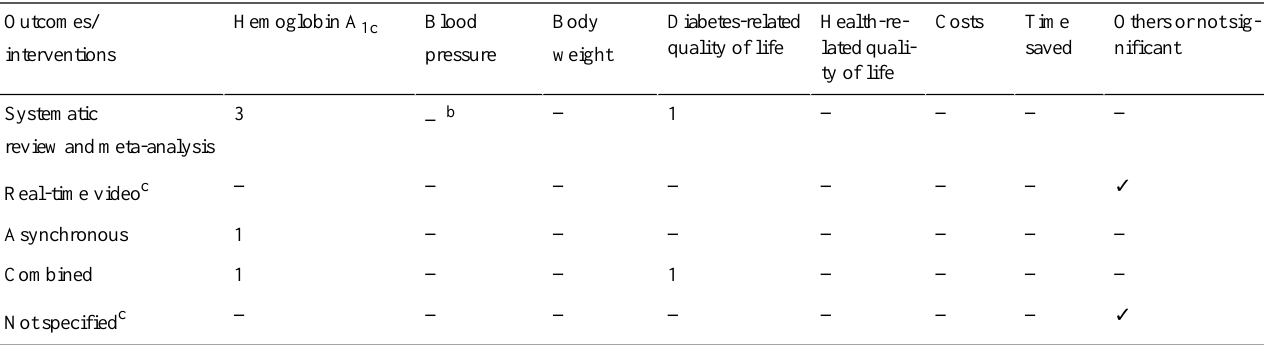
Table 2. Impact of the interventions on selected outcomes (intragroup and intergroup) (n=17).